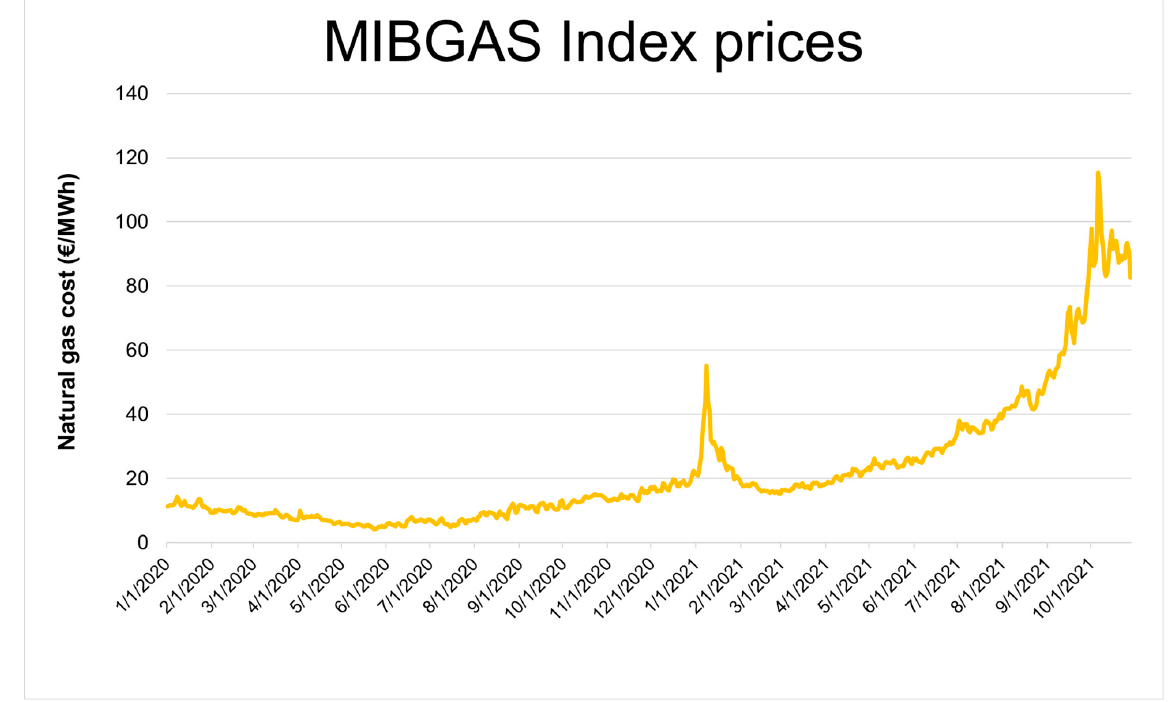
Figure 3. MIBGAS natural gas evolution for the period 2020–2021.